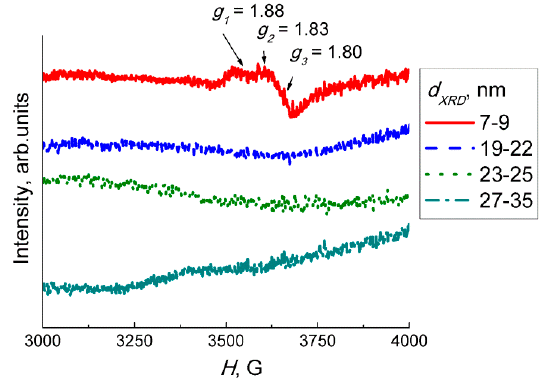
Figure 5. EPR spectra of WO 3 samples with different grain sizes.